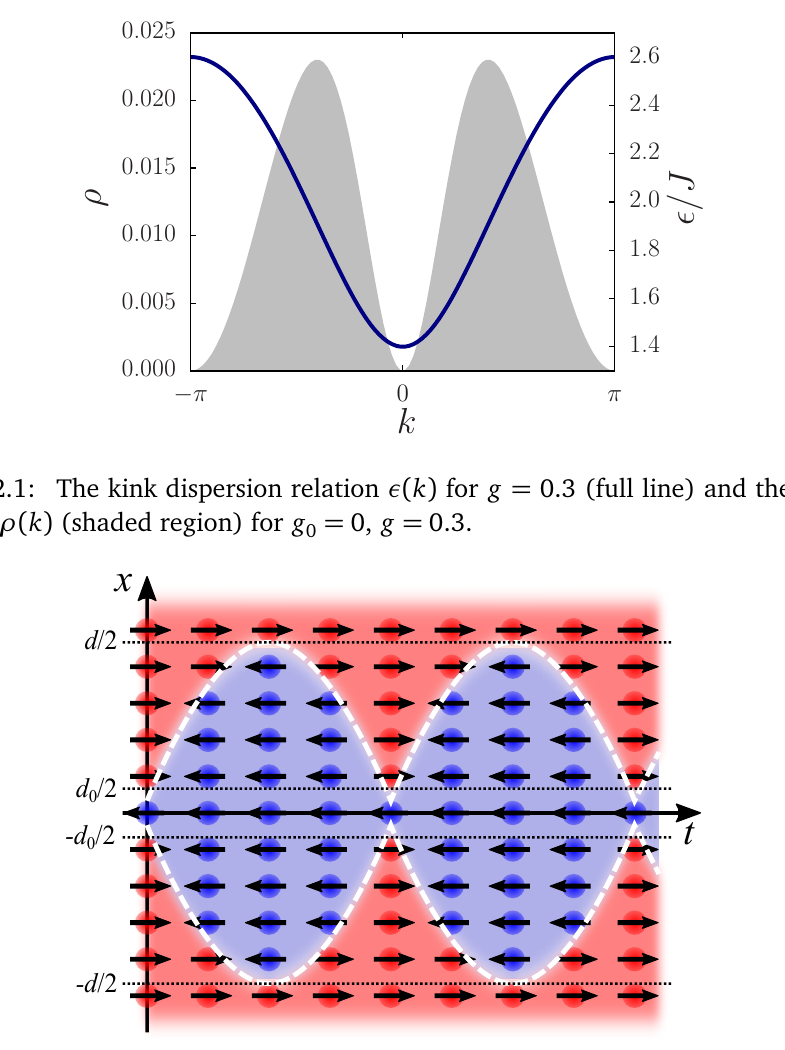
Figure 2.2: Illustration of Bloch oscillation of a bubble with a definite initial momen- tum of the kinks forming the bubble walls. Arrows indicate dominant spin directions in space and time. Time delays at kink collisions are